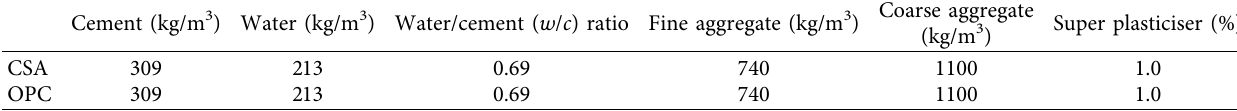
Table 1: Mixing designs of CSA and OPC concrete.